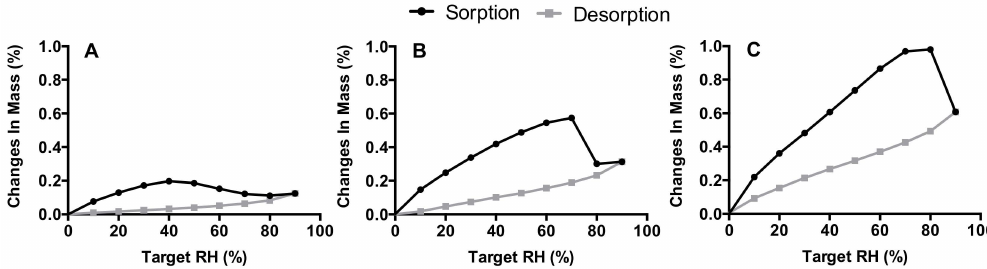
Figure 6. The dynamic vapor sorption (DVS) results. ( A ) shows the 3% trileucine formulation, spray-dried at 120 ◦ C, ( B ) the 1% trileucine formulation, and ( C ) the 3% trileucine formulation. Both spray-dried at 40 ◦ C.